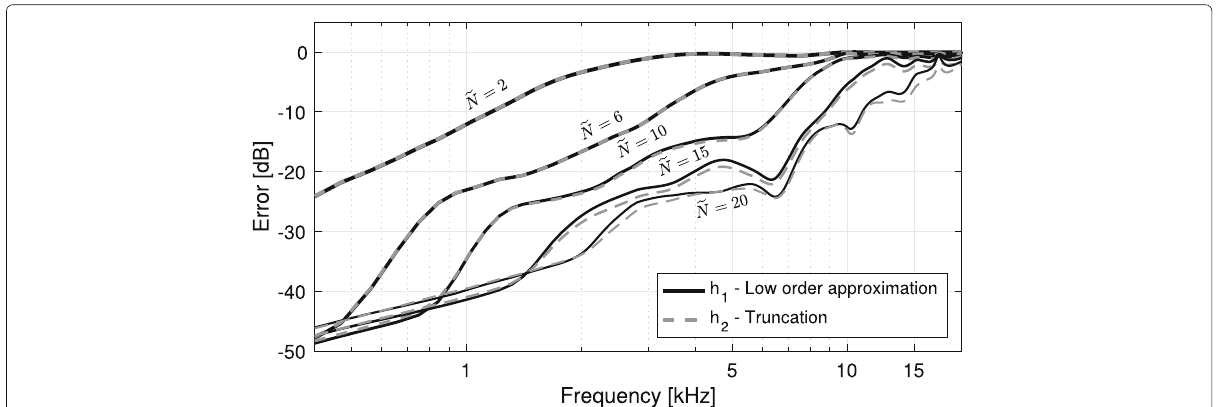
Fig. 4 Reconstruction error, using methods of truncation and direct low-order reconstruction. Computed using Eq. (12), for (cid:12) h L = h 1 , h